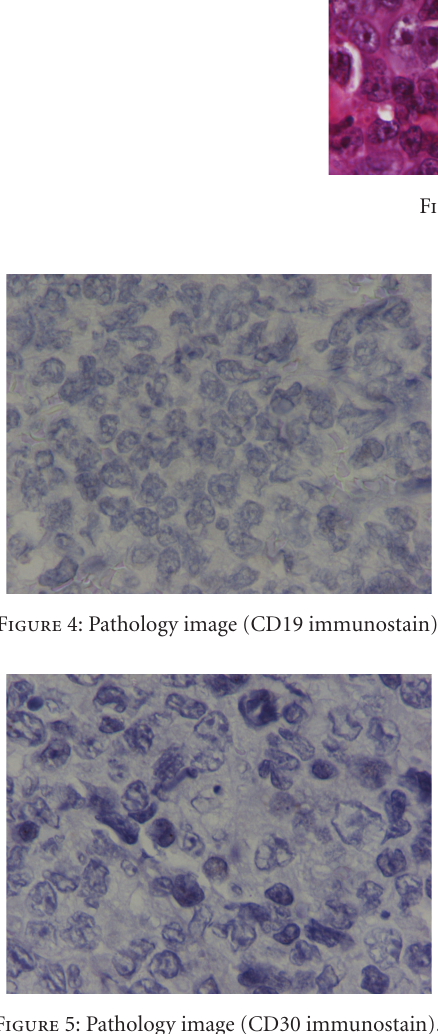
Figure 5: Pathology image (CD30